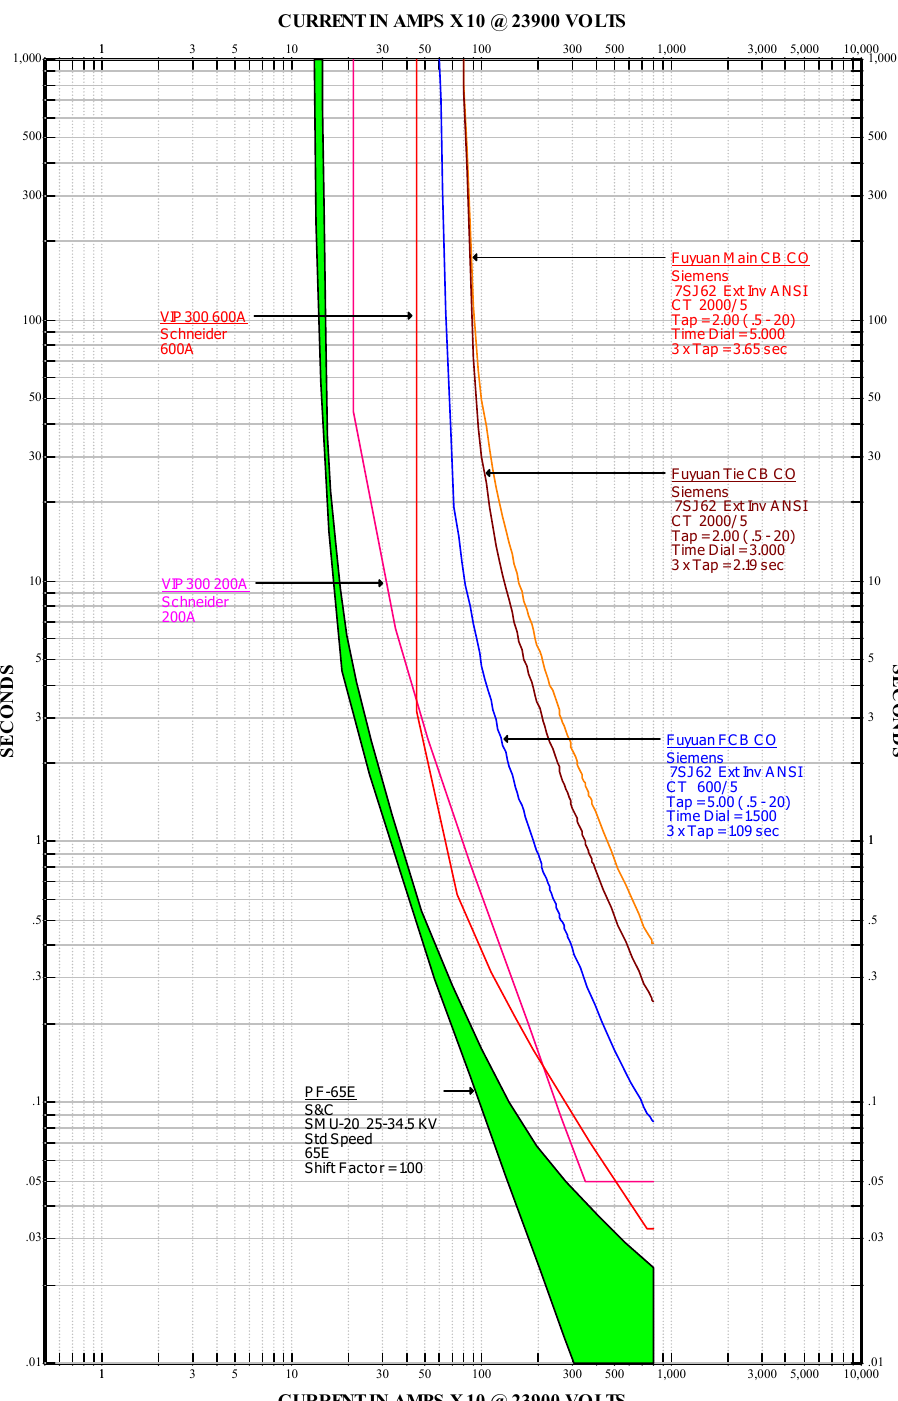
Figure 11. Original CO relays of Fuyuan